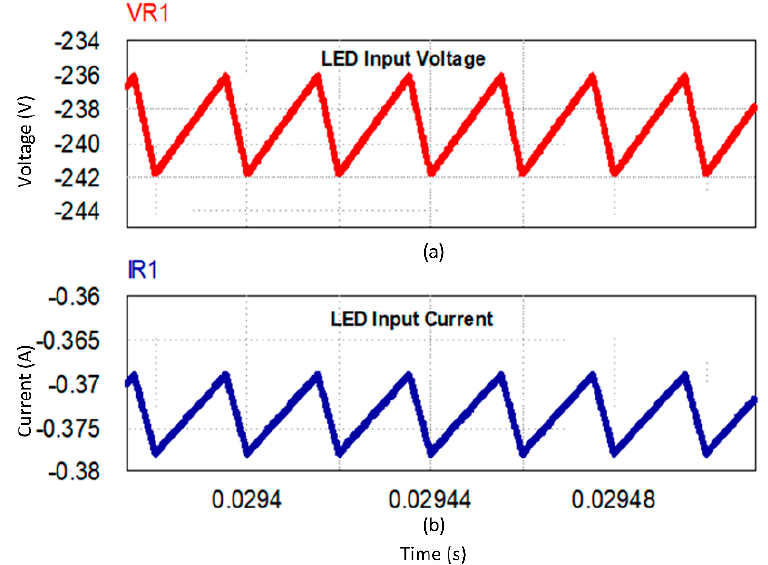
Figure 7. LED Input Voltage and Current Waveforms. LED Input Voltage Ripple: 0.83% Current Ripple: 1.06%. (a)LED input voltage; (b) LED input current.